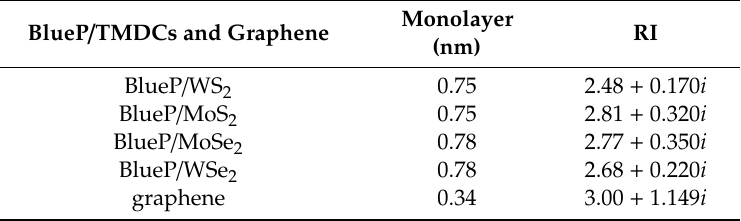
Figure 1. Schematic diagram of Ag- Indium tin oxide (ITO)-Blue Phosphorene (BlueP) / transition metal dichalogenides (TMDCs)–graphene enhanced Goos–Hänchen (GH) shift of surface plasmon resonance (SPR) sensor. Table 1. The monolayer and refractive index (RI) of Blue Phosphorene (BlueP) / transition metal dichalogenides (TMDCs) and graphene at λ = 632.8